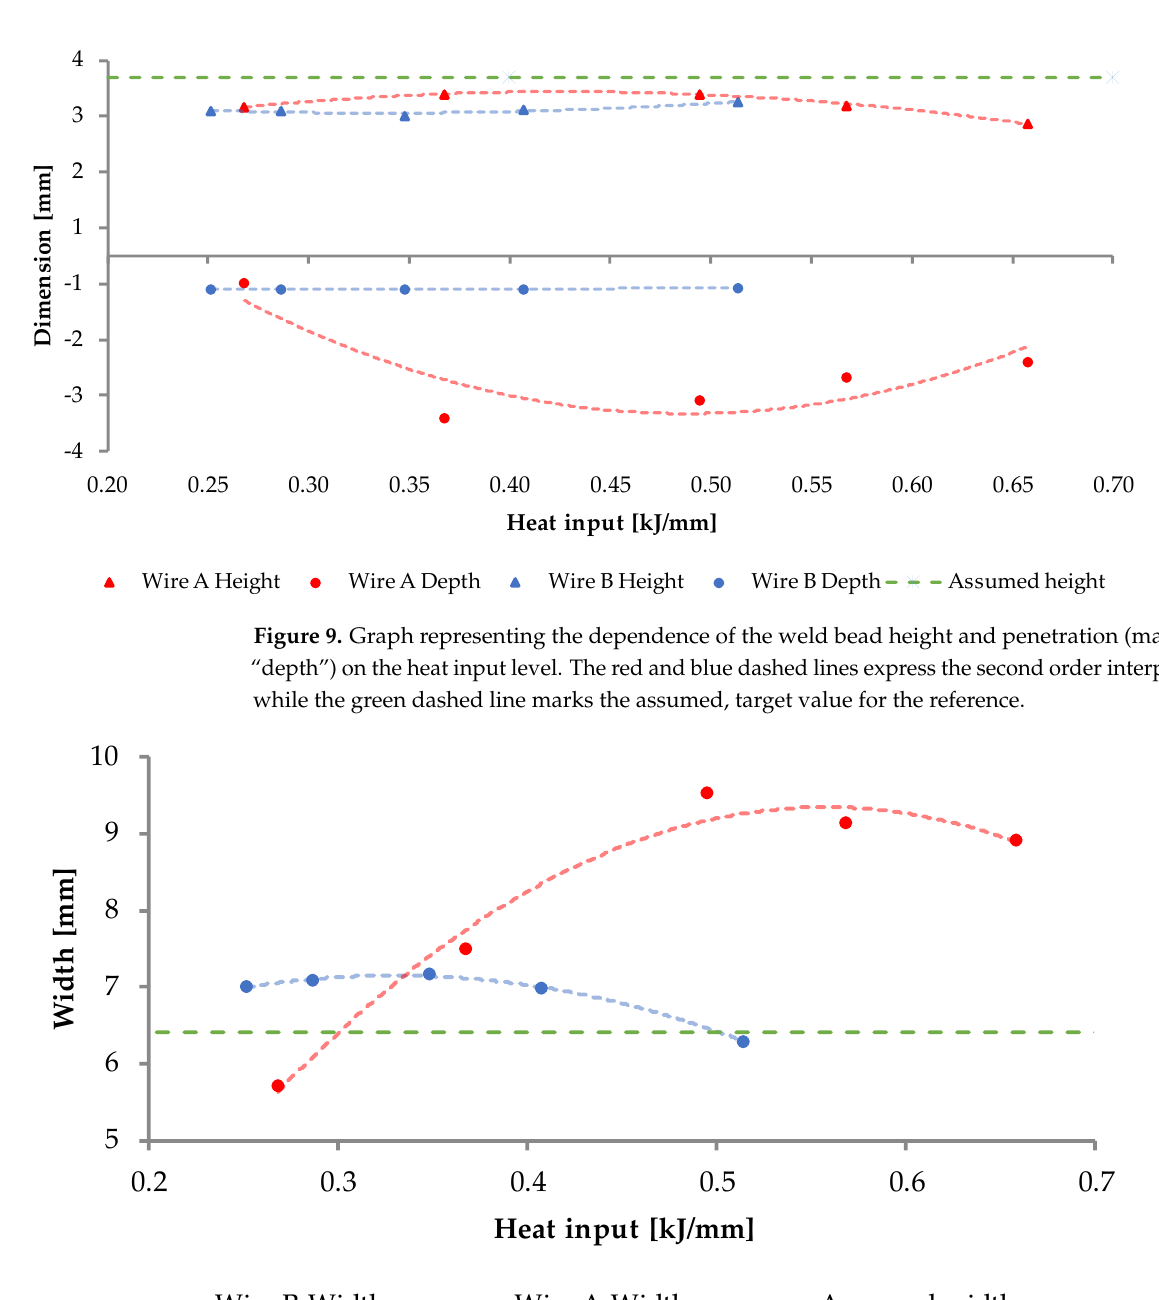
11 of 22 Figure 8. A collage of microscopic images collected for the stringer bead of Wire B. The bead